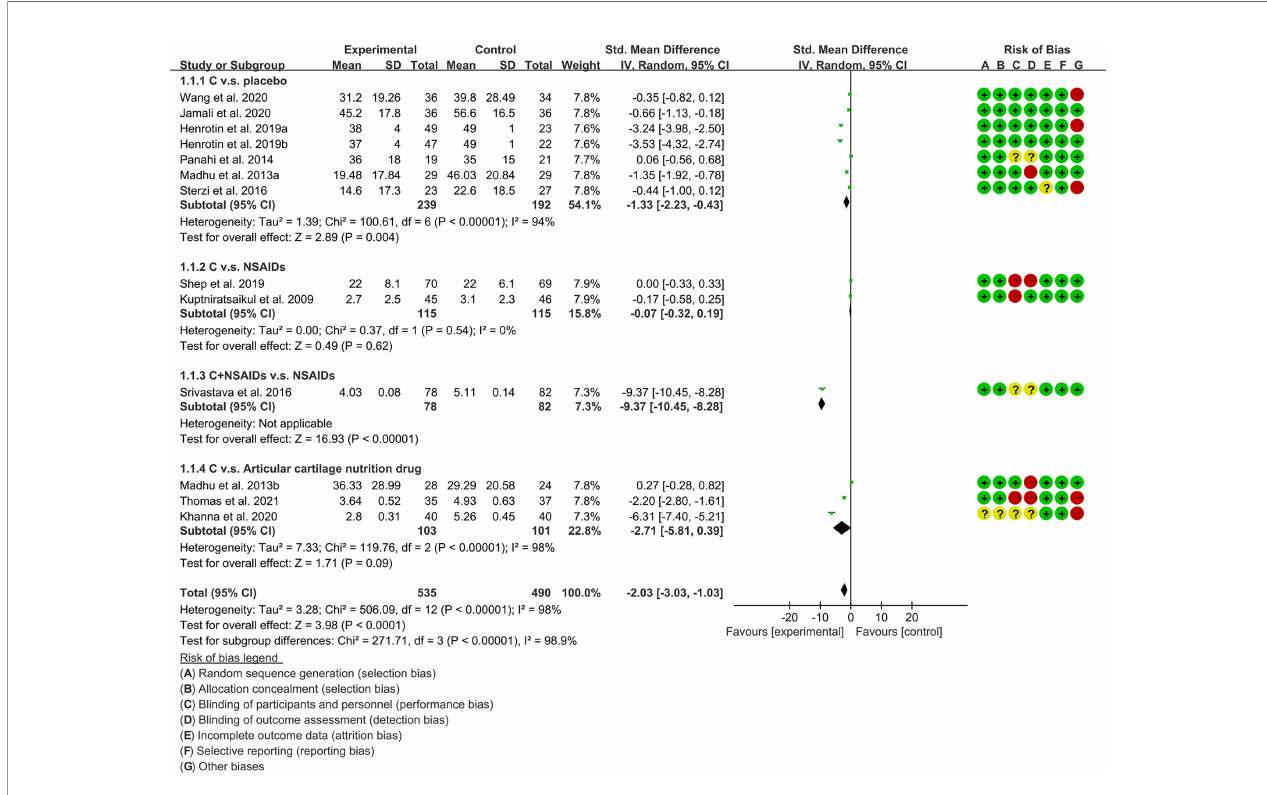
FIGURE 7 | The results of VAS.